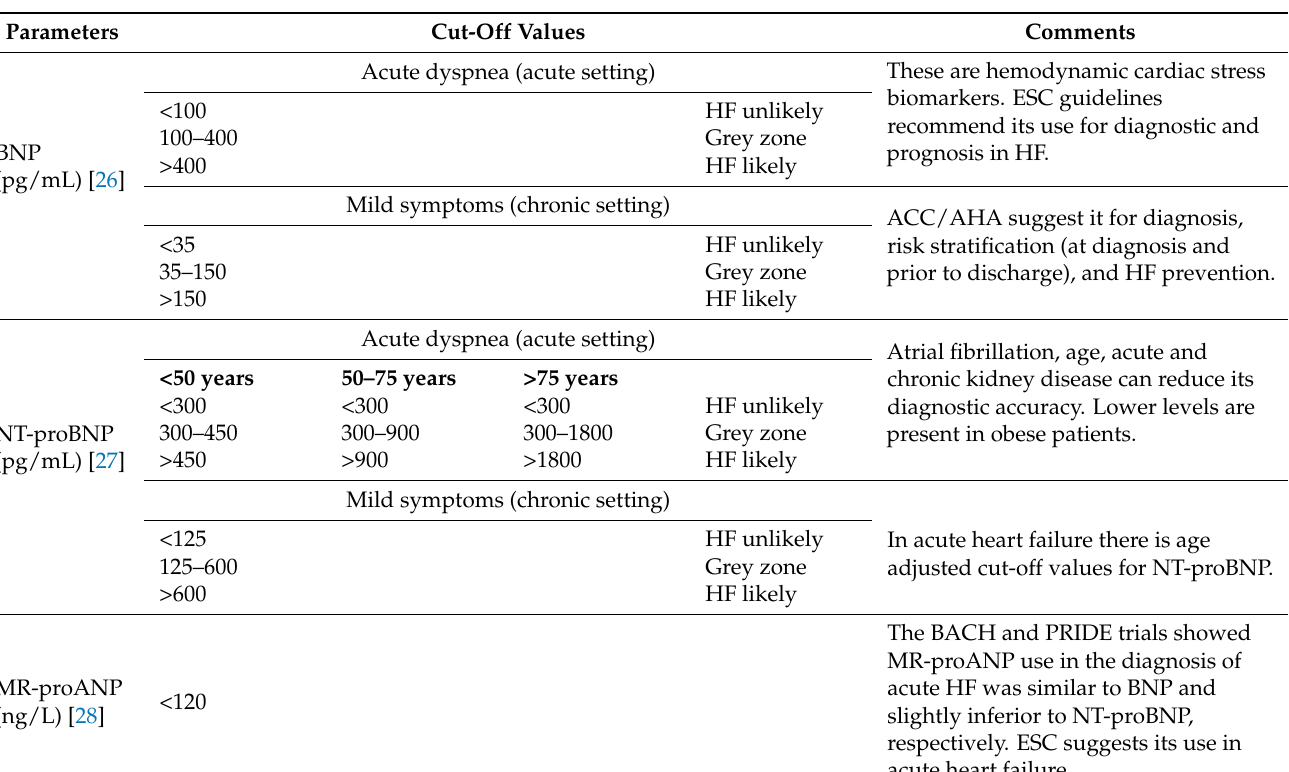
Table 2. Serology study recommended in HFpEF